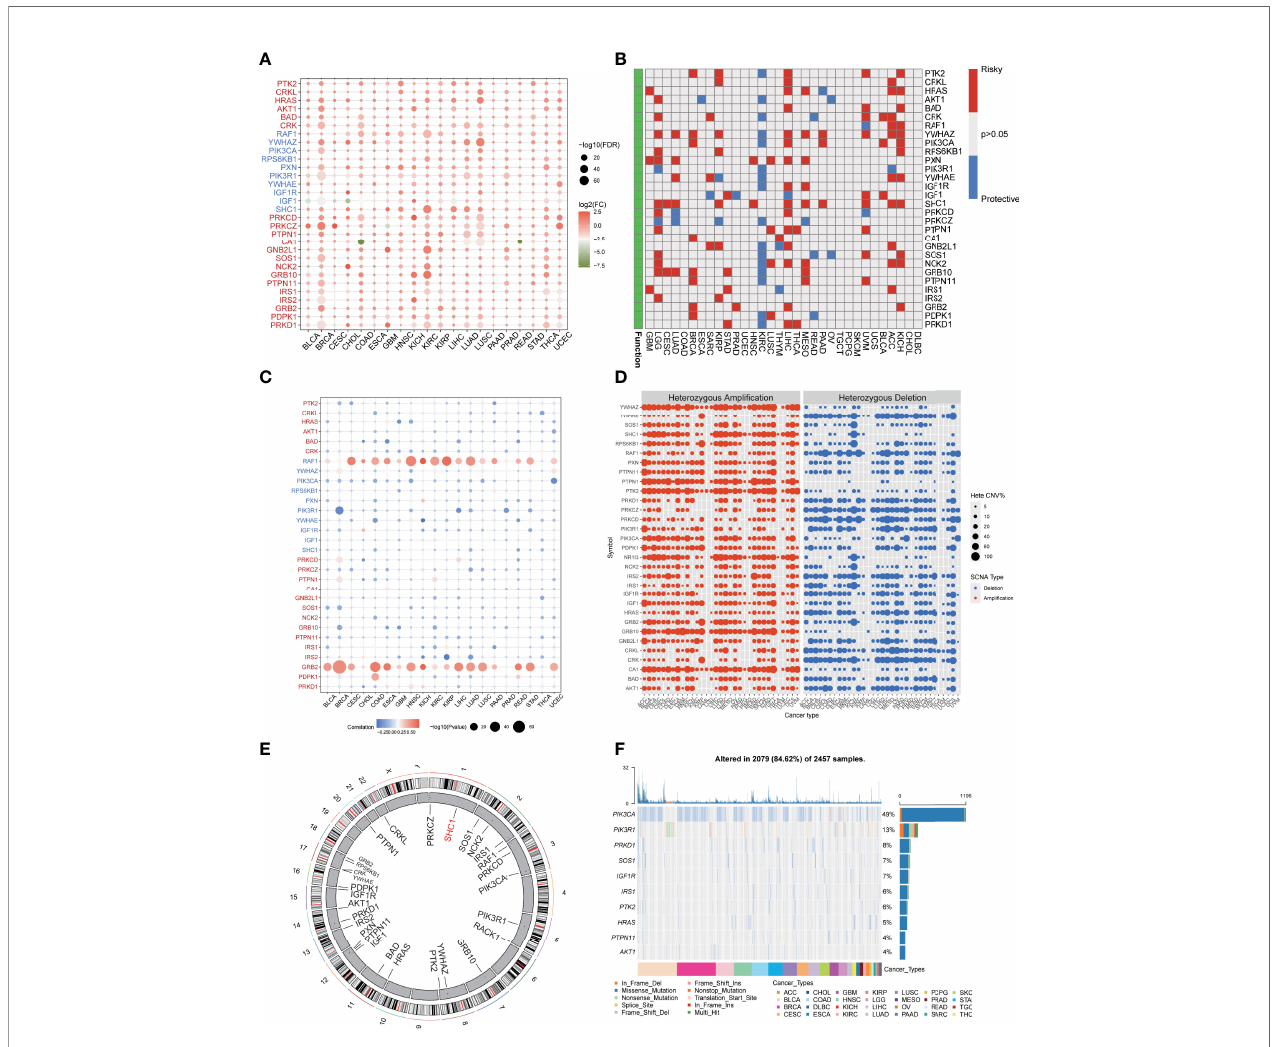
FIGURE 1 | Dysregulation and genome alteration of IGF regulator genes in cancers. (A) The gene expressions of IGF regulator genes between multi cancers tissues and normal tissues. (B) The association between expression of IGF regulator genes and patient survival. (C) The correlation analysis of CNV with gene expression of IGF regulator genes. (D) Heterozygous ampli fi cation or deletion of IGF regulator genes in multi cancers. (E) The genome locations of IGF regulator genes on 23 chromosomes. (F) Mutation frequency and type of IGF regulator genes in multi